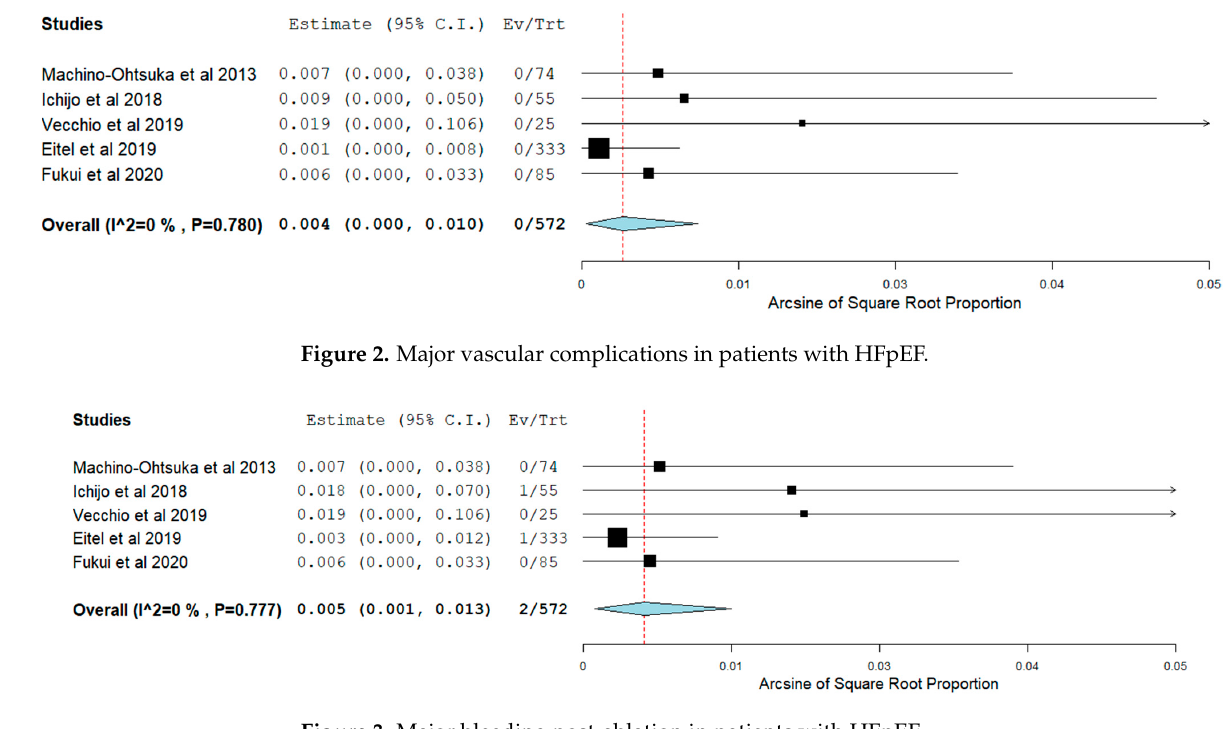
Figure 3. Major bleeding post-ablation in patients with HFpEF.